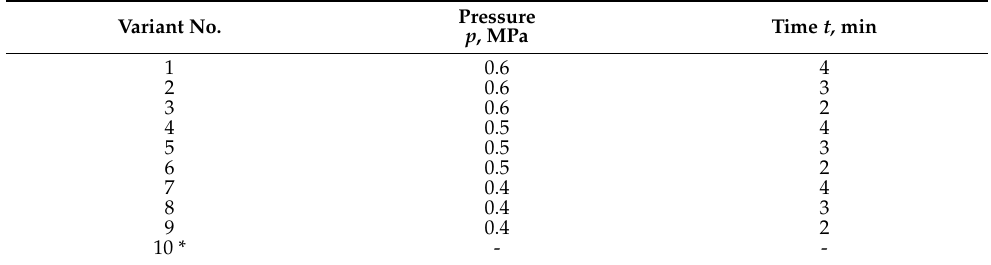
Table 4. Shot peening parameters of the experimental tests according to the PS/DK 3 2 plan. Variant No.